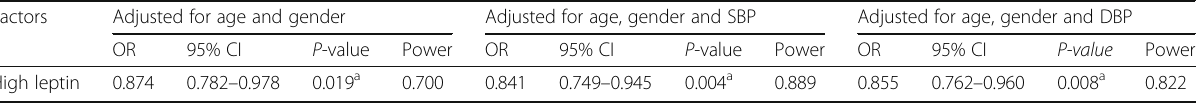
Table 2 Association of rs11191548 with high leptin under the additive model Factors Adjusted for age and gender Adjusted for age, gender and SBP Adjusted for age, gender and